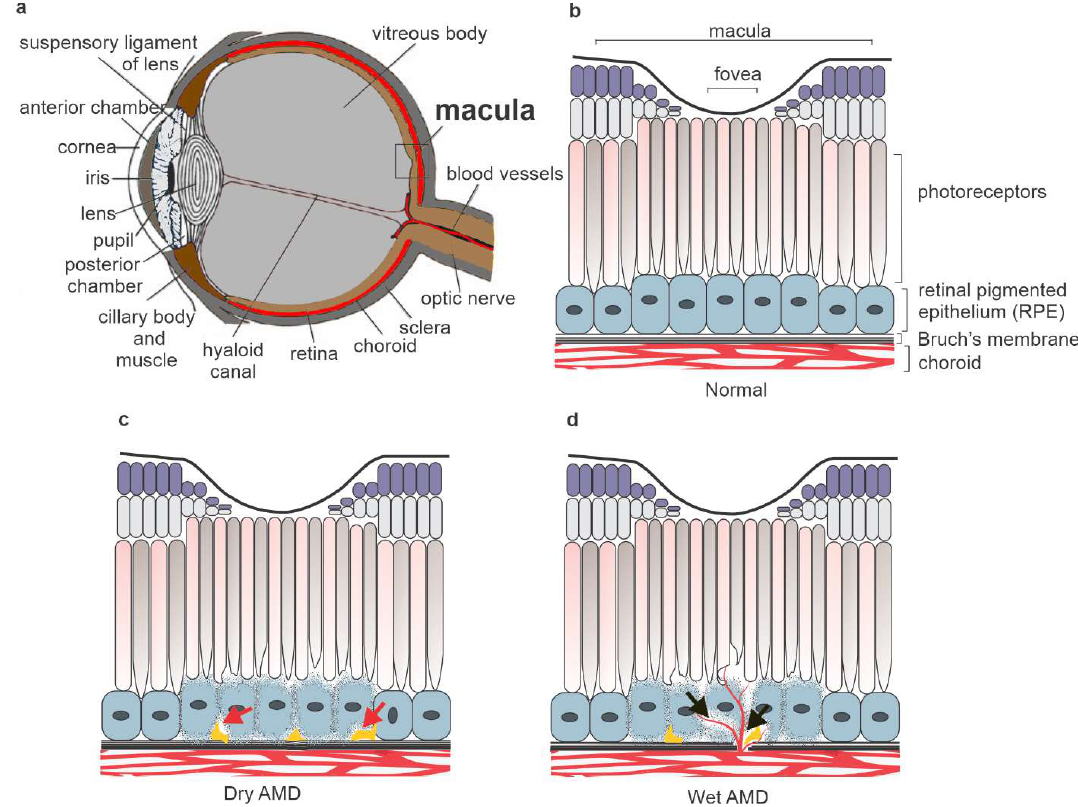
Figure 1. A cross-section of the human eye ( a ). The main outer retina layers in the healthy eye ( b ). The accumulation of drusen deposits (red arrow) and degeneration of retinal pigment epithelium (RPE) cells are detected in dry age-related macular degeneration (AMD) ( c ). Together with the dry AMD signs, choroidal neovascularization (black arrow) is a clinical hallmark of wet AMD ( d ).